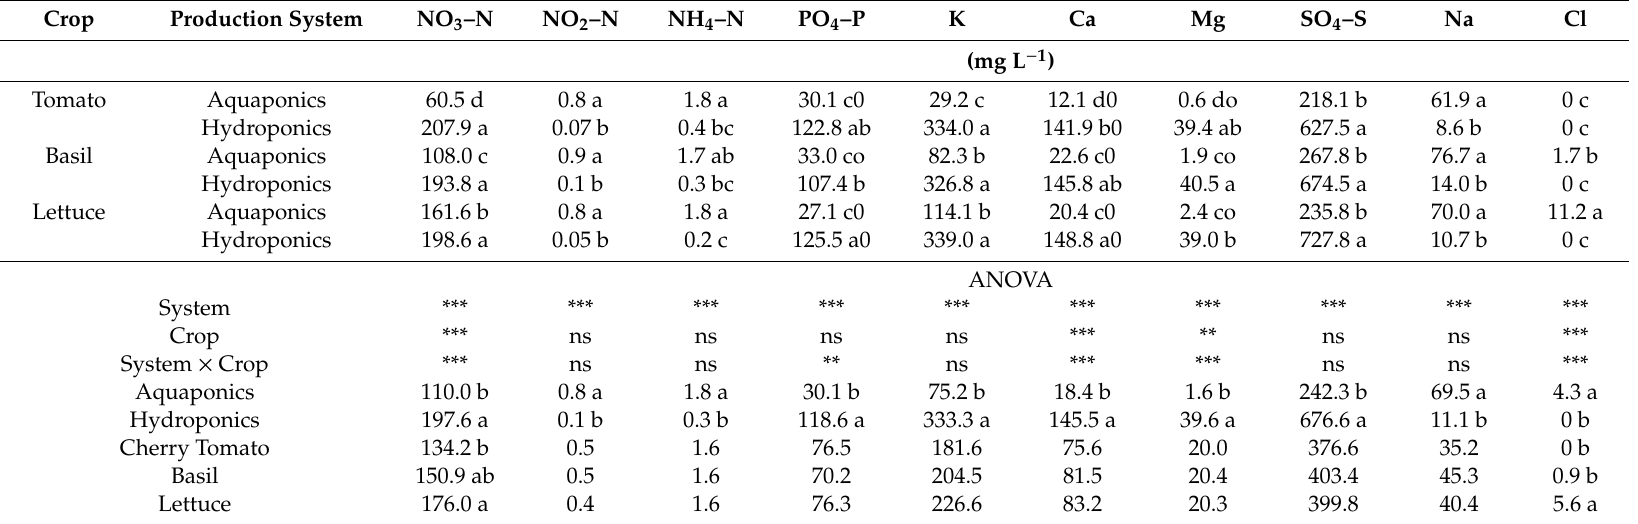
Table 7. Average mineral nutrient concentrations in the aquatic phase of tomato-, basil-, or lettuce-based aquaponic and hydroponic systems during a 3-month production